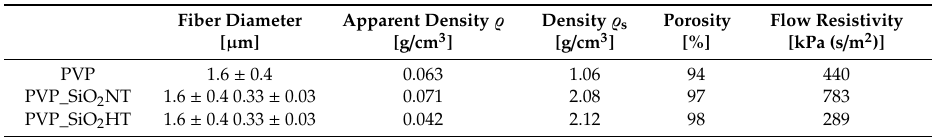
Table 1. Fiber diameter, densities, porosity and flow resistivity of PVP, PVP_SiO 2 NT and PVP_SiO 2 HT blankets.